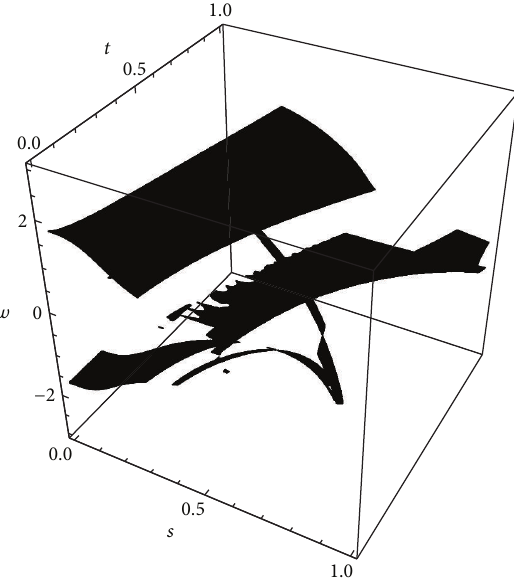
Figure 6: CC region in the trapezoidal 5-body problem where all the masses are positive.